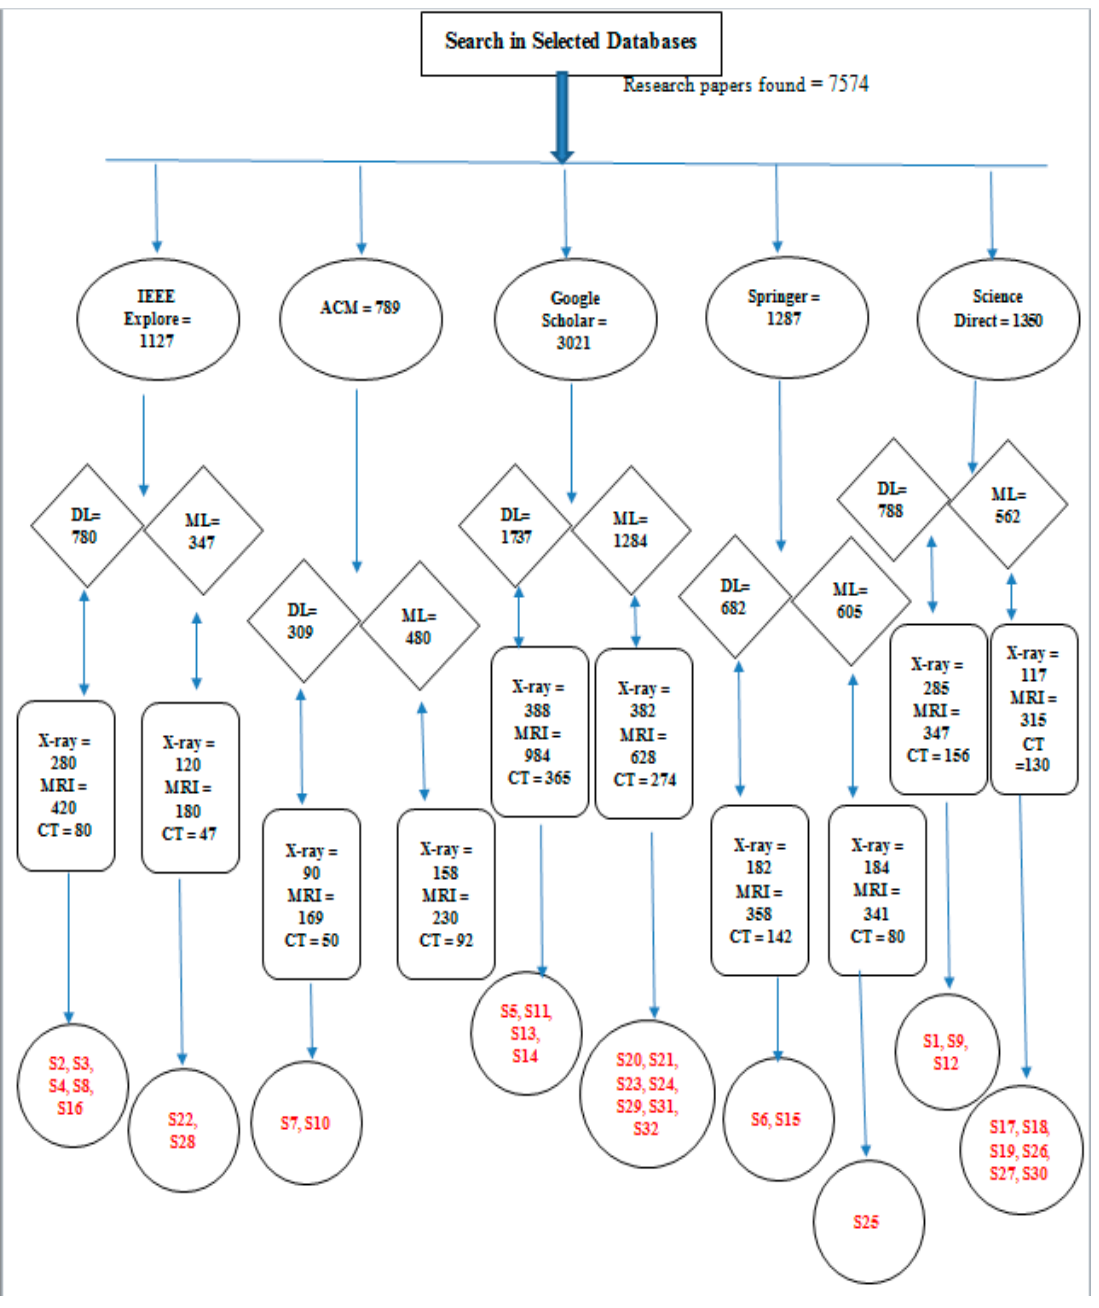
Figure 3. Hierarchy of number of Studies for SLR.